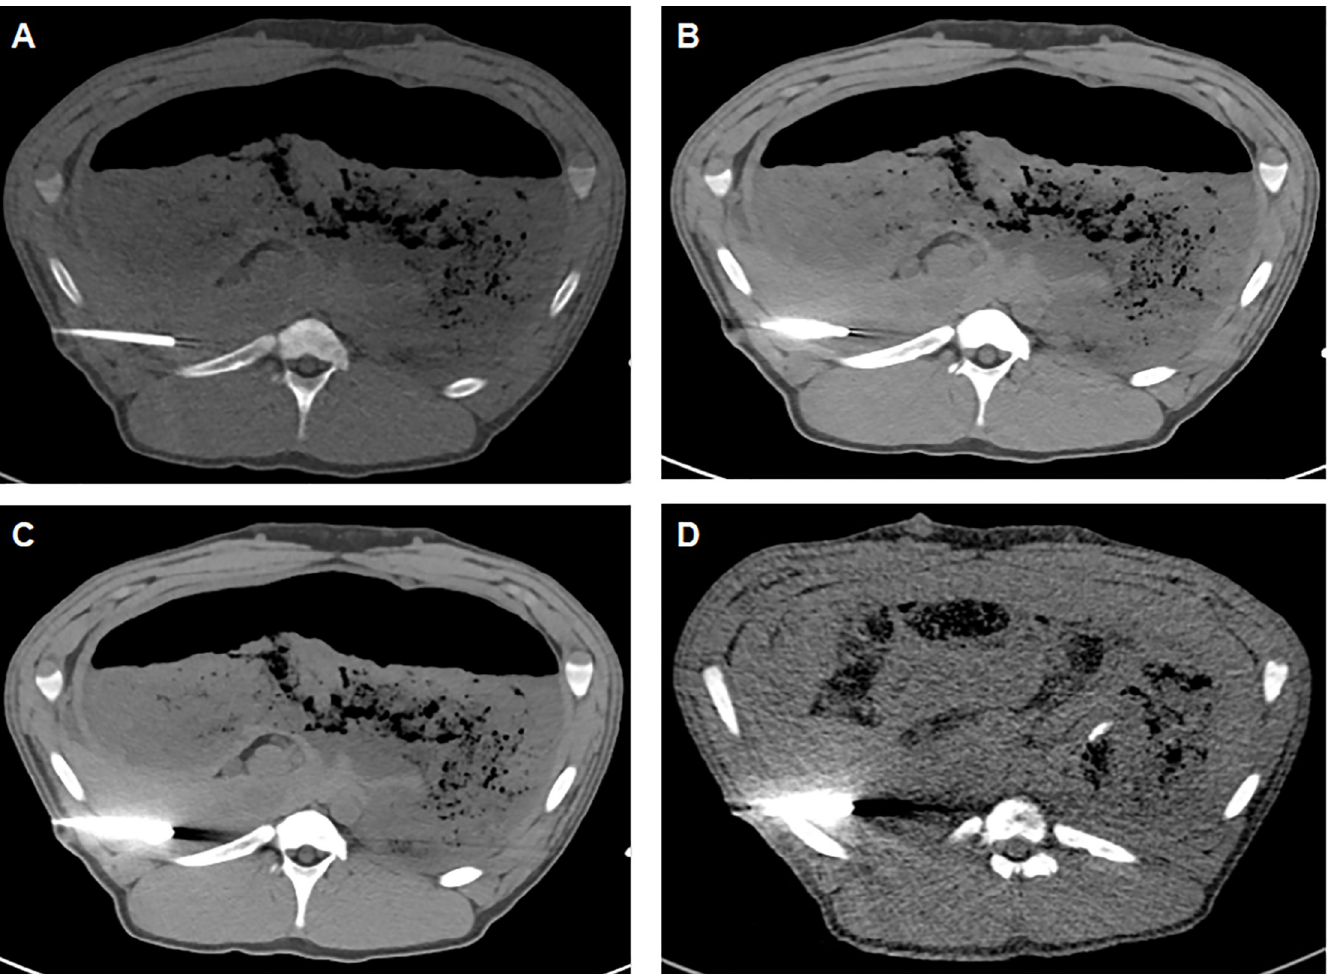
Fig 3. Examples of qualitative image analysis. Semi-quantitative score for artifacts bordering the trocar tip (A: none; B: mild; C: moderate; D: severe).